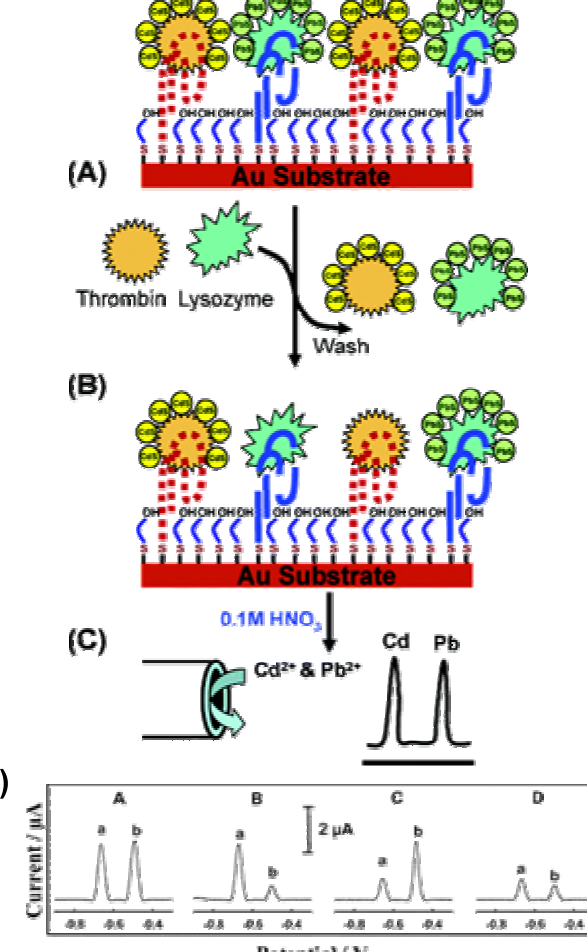
Figure 8. Electrochemical Detection with Quantum